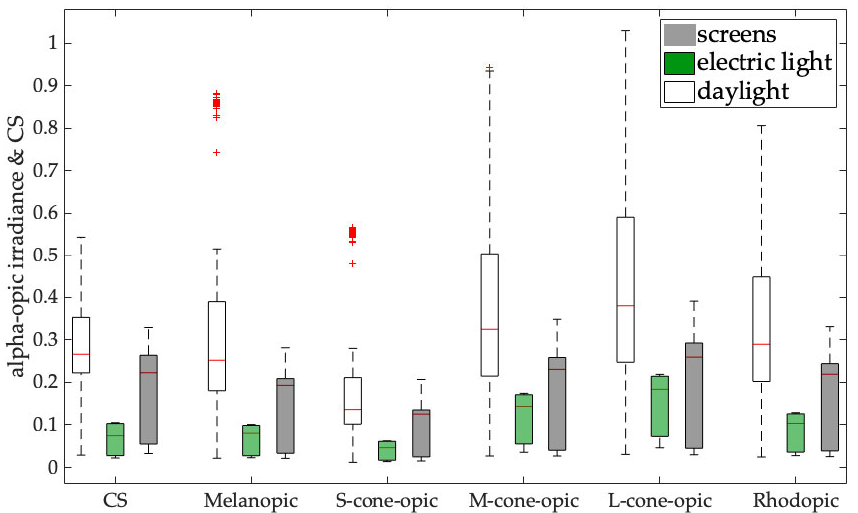
Figure 1. The α -opic irradiance and circadian stimulus ( CS ) for each of the three main sources of light in offices in commercial buildings. The red horizontal lines that divide the boxes into two parts mark the median (middle quartile). The boxes represent the inter-quartile range (the middle 50%) and the upper and lower whiskers show the highest and lowest non-outliers. The red crosses outside the boxes show the outliers.